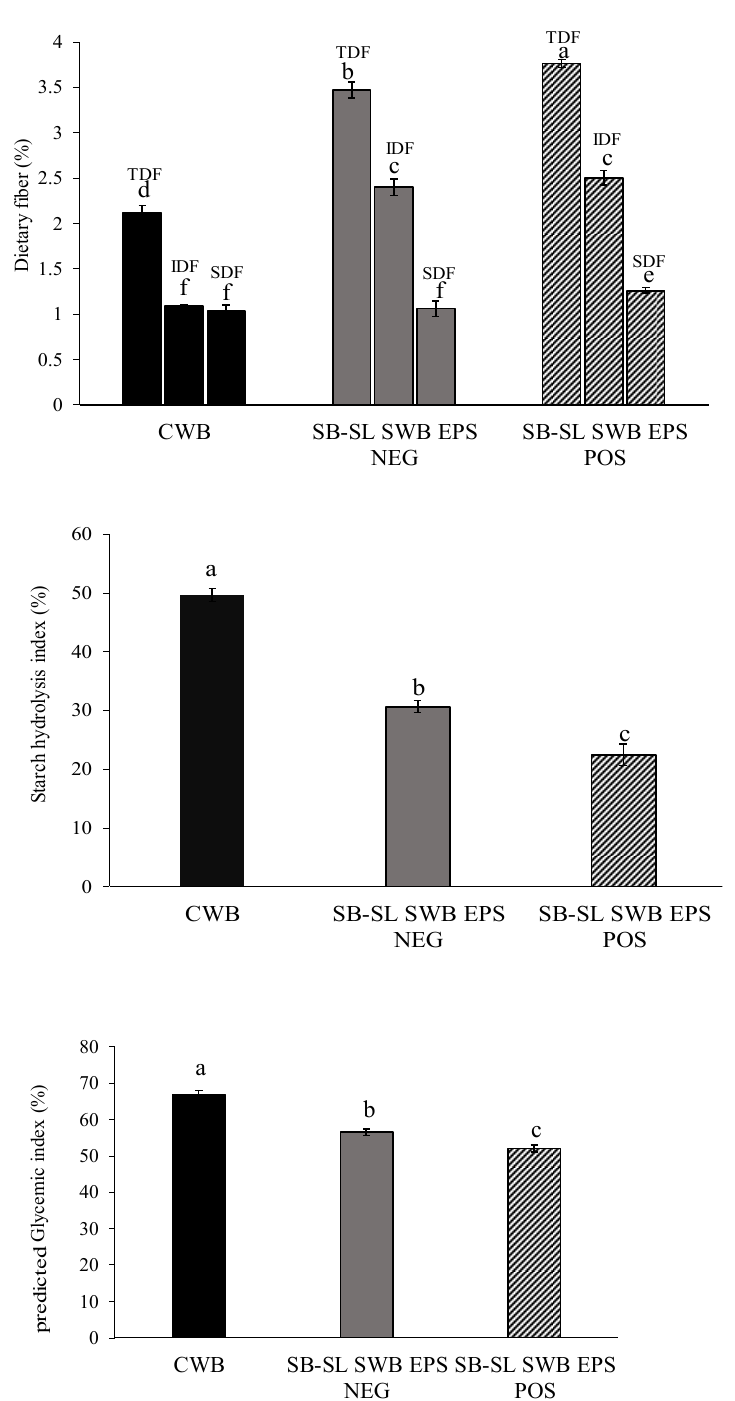
Figure 3. Nutritional characteristics of control and sourdough breads (DY 162). CWB, control wheat bread started with baker’s yeast; SB-SL SWB EPS NEG, bread containing wheat flour added with 30% ( w / w ) sprouted barley–sprouted lentil (30:70% w / w ) sourdough fermented by Leuconostoc pseudomesenteroides DSM 20193; SB-SL SWB EPS POS, bread containing wheat flour added to 30% ( w / w ) dextran-containing sprouted barley–sprouted lentil (30:70% w / w ) sourdough fermented by L. pseudomesenteroides DSM 20193. fibers. The initial cell density of the strain was ca. 7 log cfu/g. The sourdough was fermented at 20 ◦ C for 24 h. TDF, total dietary fibers; IDF, insolu- ble dietary fibers; SDF, soluble dietary. For each bread, bars with different superscript letters differ significantly ( p <